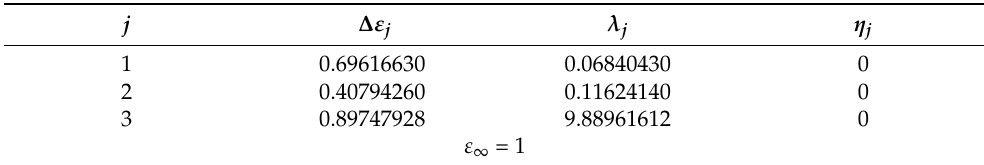
Table 2. Parameters for the Sellmeier ‘s permittivity model of quartz calculated using experi- mental results in [54].